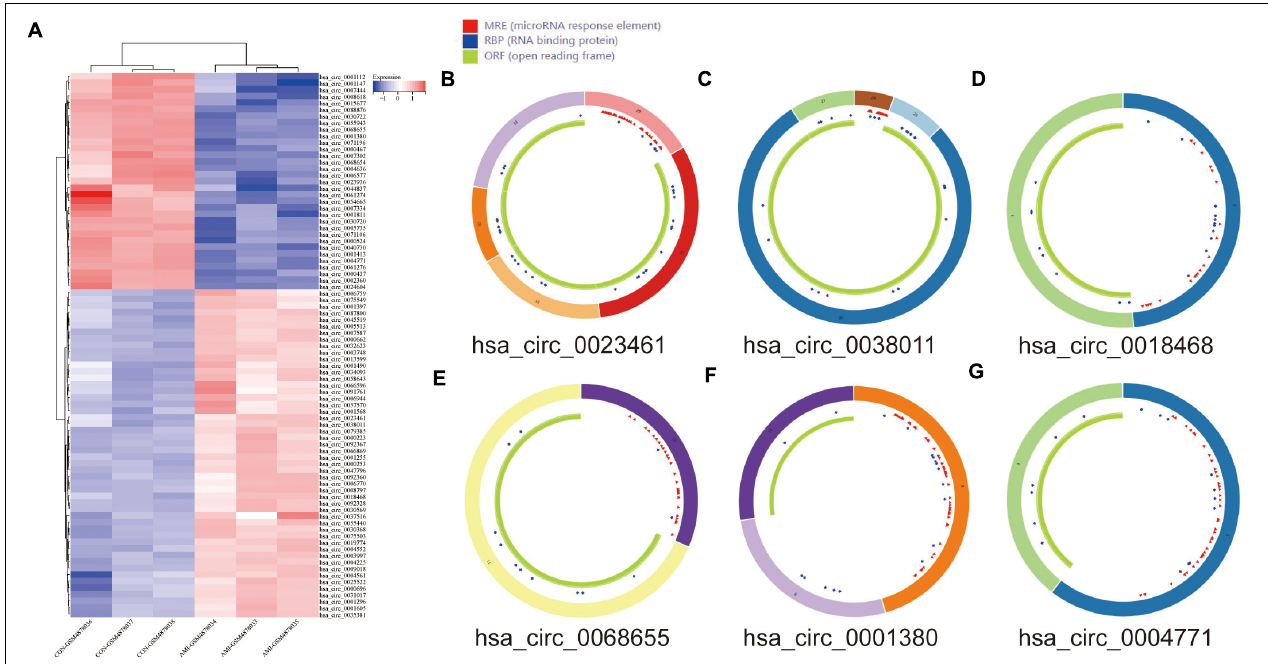
FIGURE 3 | DEcircRNAs in GES160717. (A) Heatmap of DEcircRNAs in GSE160717. (B) Structural pattern of hsa_circ_0023461. (C) Structural pattern of hsa_circ_0038011. (D) Structural pattern of hsa_circ_0018468. (E) Structural pattern of hsa_circ_0068655. (F) Structural pattern of hsa_circ_0001380. (G) Structural pattern of hsa_circ_0004771.